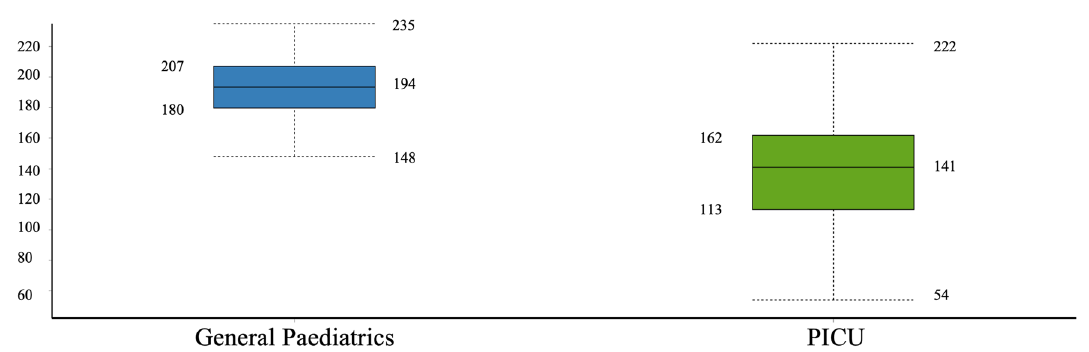
Figure 5. Boxplot of bacteriophages in GPD versus PICU wards (CHAO1